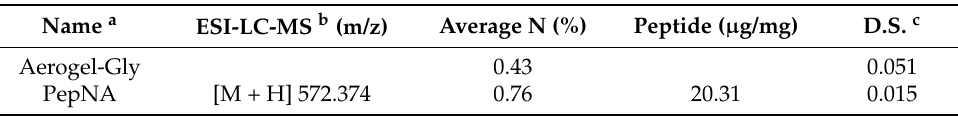
Table 1. Mass spectral, quantitative peptide incorporation and degree of substitution values obtained for the aerogels.